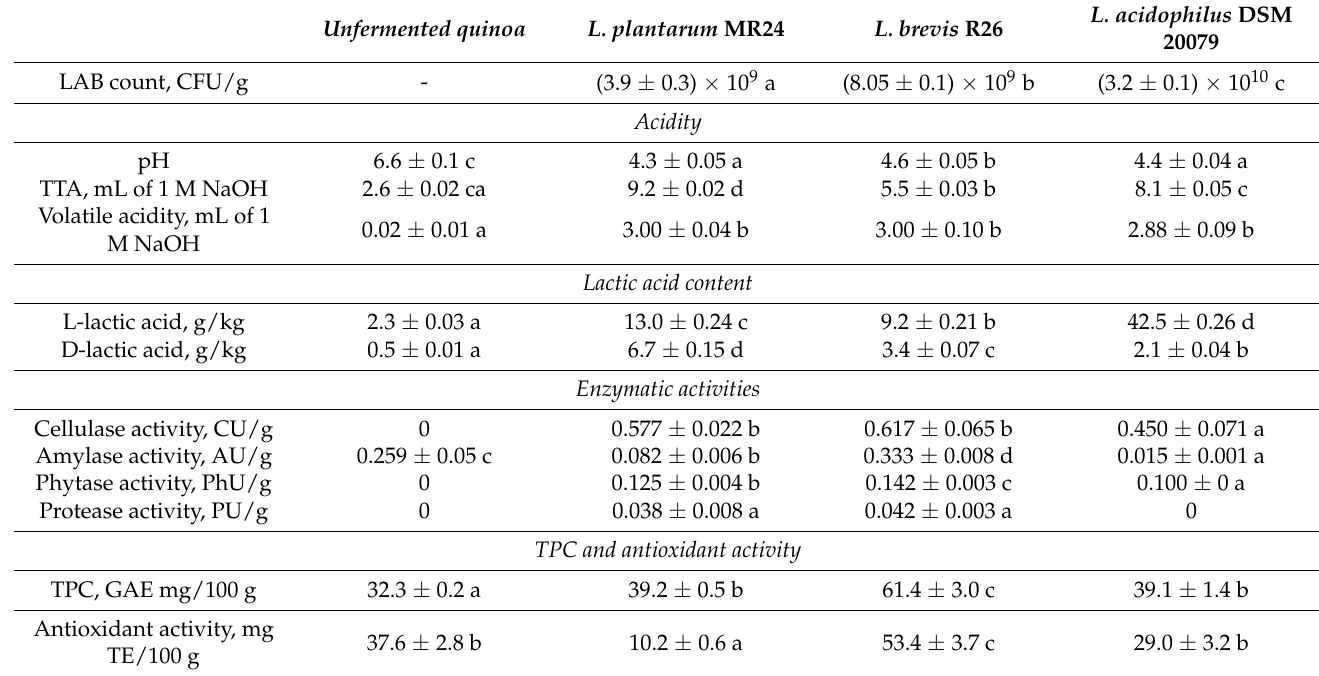
Table 1. Characteristics of quinoa fermented with different LAB strains for 72 h. Unfermented